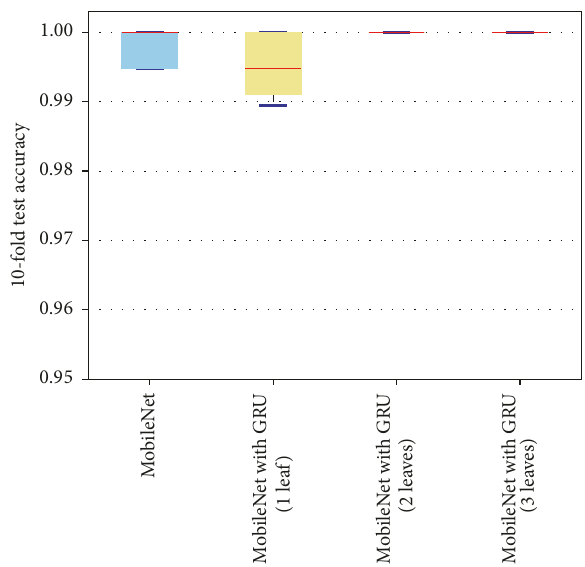
Figure 5: The MobileNet with GRU model compared with tradi- tional transfer learning.